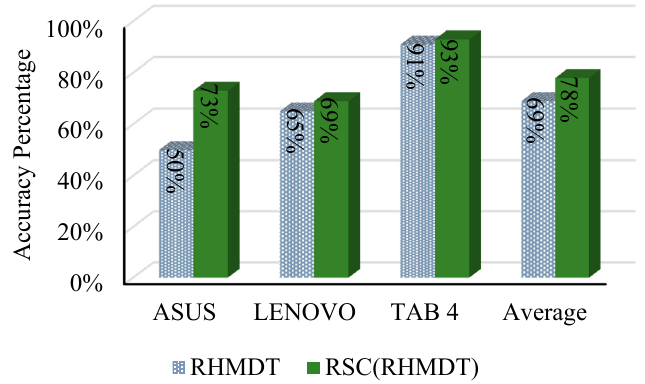
Figure 18. Room positioning accuracy percentage before and after applying RSC, RHMDT and RSC (RHMDT).